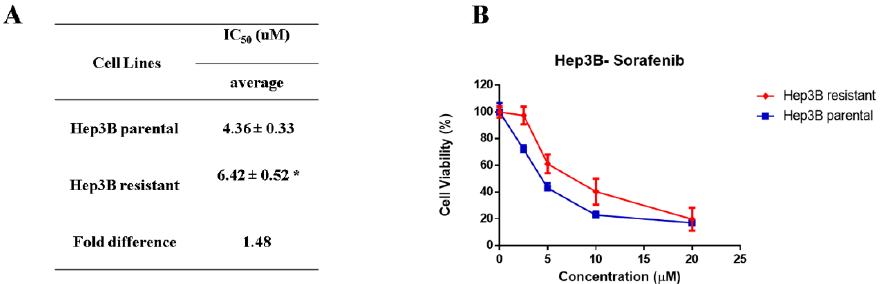
Figure 1. The generated Hep3B resistant subclones are less sensitive to sorafenib ( A ) Table represen- tation of the IC50 of sorafenib in parental and resistant Hep3B cells after 48 h treatment. IC50 are means ± SD of three individual experiments ( n = 3), * ( p value < 0.05). ( B ) Concentration-response curves of sorafenib parental Hep3B cells and the resistant cells. MTT assay was conducted at 48 h after treatment. Points, mean; bars, SD ( n = 3).